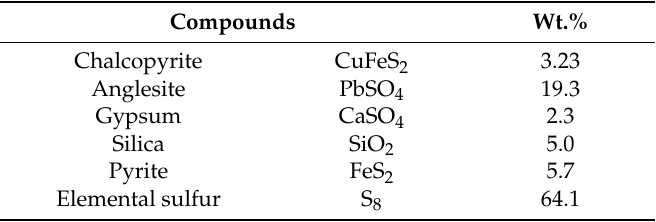
Table 7. Mineralogical reconstruction of the leaching residue in test